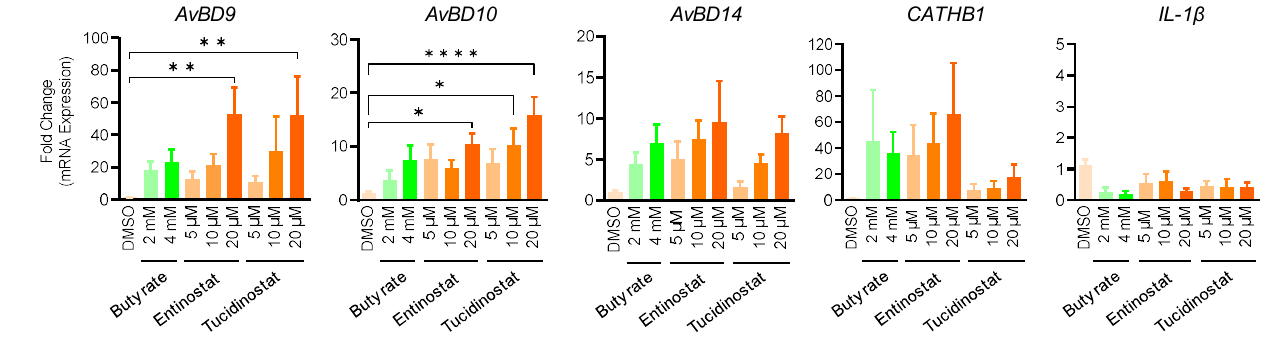
Figure 7. Regulation of HDP and IL-1β gene expression in chicken jejunal explants by entinostat and tucidinostat. Jejunal explants were stimulated in triplicate with or without indicated concentrations of either compound for 24 h, followed by RT-qPCR analysis. DMSO was added as a negative control. The results are means ± SEM of 3 independent experiments. * p < 0.05, ** p < 0.01, **** p < 0.0001 (by one-way ANOVA and post-hoc Dunnett’s multiple comparisons test).